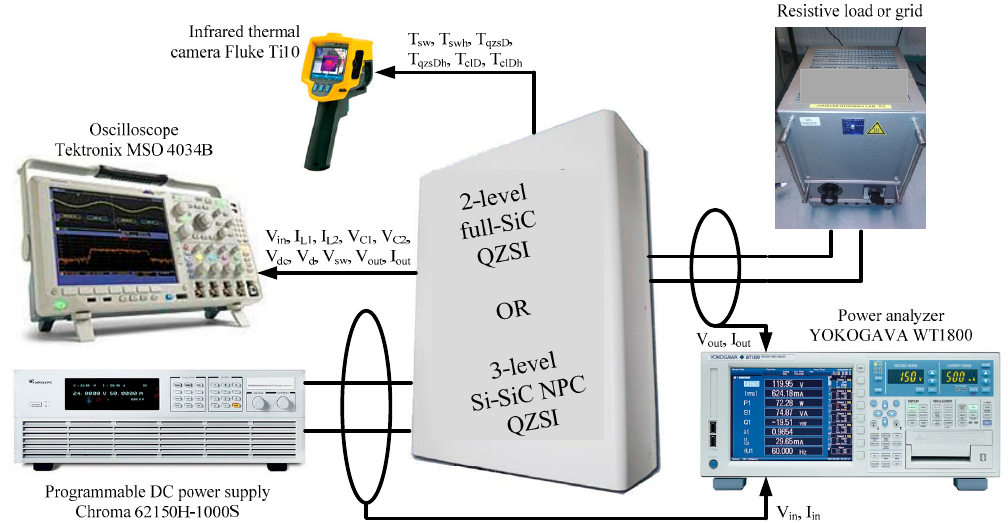
Figure 4. The structure of the experimental verification setup.